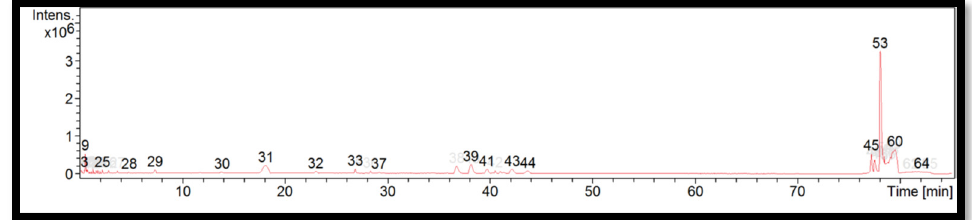
Figure 1. LC-MS/MS chromatogram of B. multiplex . The liquid chromatogram of the LC-MS/MS analysis for B. tuldoides is shown in Figure 2. The compounds identified in B. tuldoides are tabulated in Table 6 along with their molecular formula, molecular weight, and m / z value. In the present study, 14 detected peaks showed significance. The highest peak was found to be felodipine (peak 35). In B. tuldoides , alkaloid compounds identified as sparteine and papaverine were found in peaks 5 and 16, respectively. Other compounds found in B. tuldoides were: PET-cGMP (peak 12); naloxone (peak 14); thiopental (peak 22); cyproheptadine (peak 24); loprazolam (peak 26); difenoconazole (peak 28); RP-8-pCPT-cGMPS (peak 31); and felodipine (peak 44). The liquid chromatogram of the LC-MS/MS analysis for B. vulgaris is shown in Figure 3. The compounds identified in B. vulgaris are tabulated in Table 7 along with their molecular formula, molecular weight, and m / z value. In the present study, 13 detected peaks showed significance. The highest peak was found to be felodipine (peak 42). In B. vulgaris , alkaloid compounds identified as papaverine were found in peak 11. Other com- pounds found in B. vulgaris were: econazole (peak 3); pimozide (peak 9); cyproheptadine (peak 15); bisacodyl (peak 19); loprazolam (peak 25); difenoconazole (peak 36); felodipine (peak 51); and cinchocaine (peak